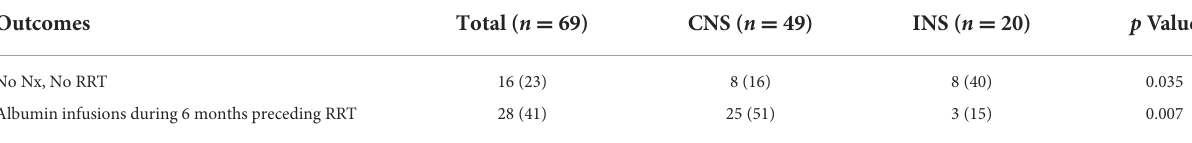
6 months preceding RRT, 3 (14%) of which did not undergo nephrectomy (Figure 4B and Table 5B). In comparison, of the 12 patients with INS who underwent RRT (11 dialysis and one pre-emptive kidney transplant), only 3 (25%) received albumin during 6 months prior to RRT ( p = 0.007, Table 5B). Eight of 49 children with CNS did not require nephrectomy or RRT, compared to 8 of 20 (40%) with INS ( χ 2 = 4.47; p = 0.04). RAAS inhibition was recorded in 8 of the 10 patients (80%) with CNS vs . 6 of the 8 patients (75%) with INS. The outcome at 12 months (Table 4) was not different between the two groups with respect to serum albumin concentration, or RRT